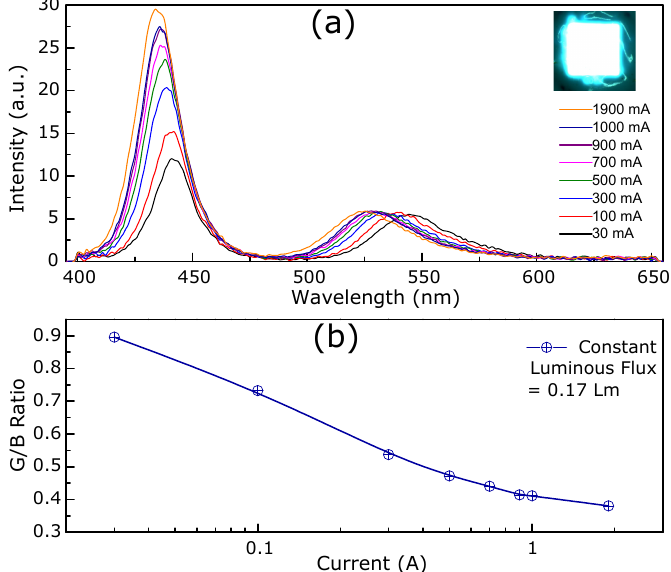
Figure 6. ( a ) Electroluminescence (EL) spectra of the MBG LEDs under pulsed excitation, pulse width changed from 17 µ s at low current amplitude (30 mA) to 0.58 µ s at high current amplitude (1.9 A), fixed period = 100 µ s (Inset: MBG LED chip. White light emission under pulsed current operation with 1.9 A peak current; the EL emission is collected from the back surface of the chip through sapphire substrate); ( b ) The dependence of integrated intensities of green and blue peaks on current at